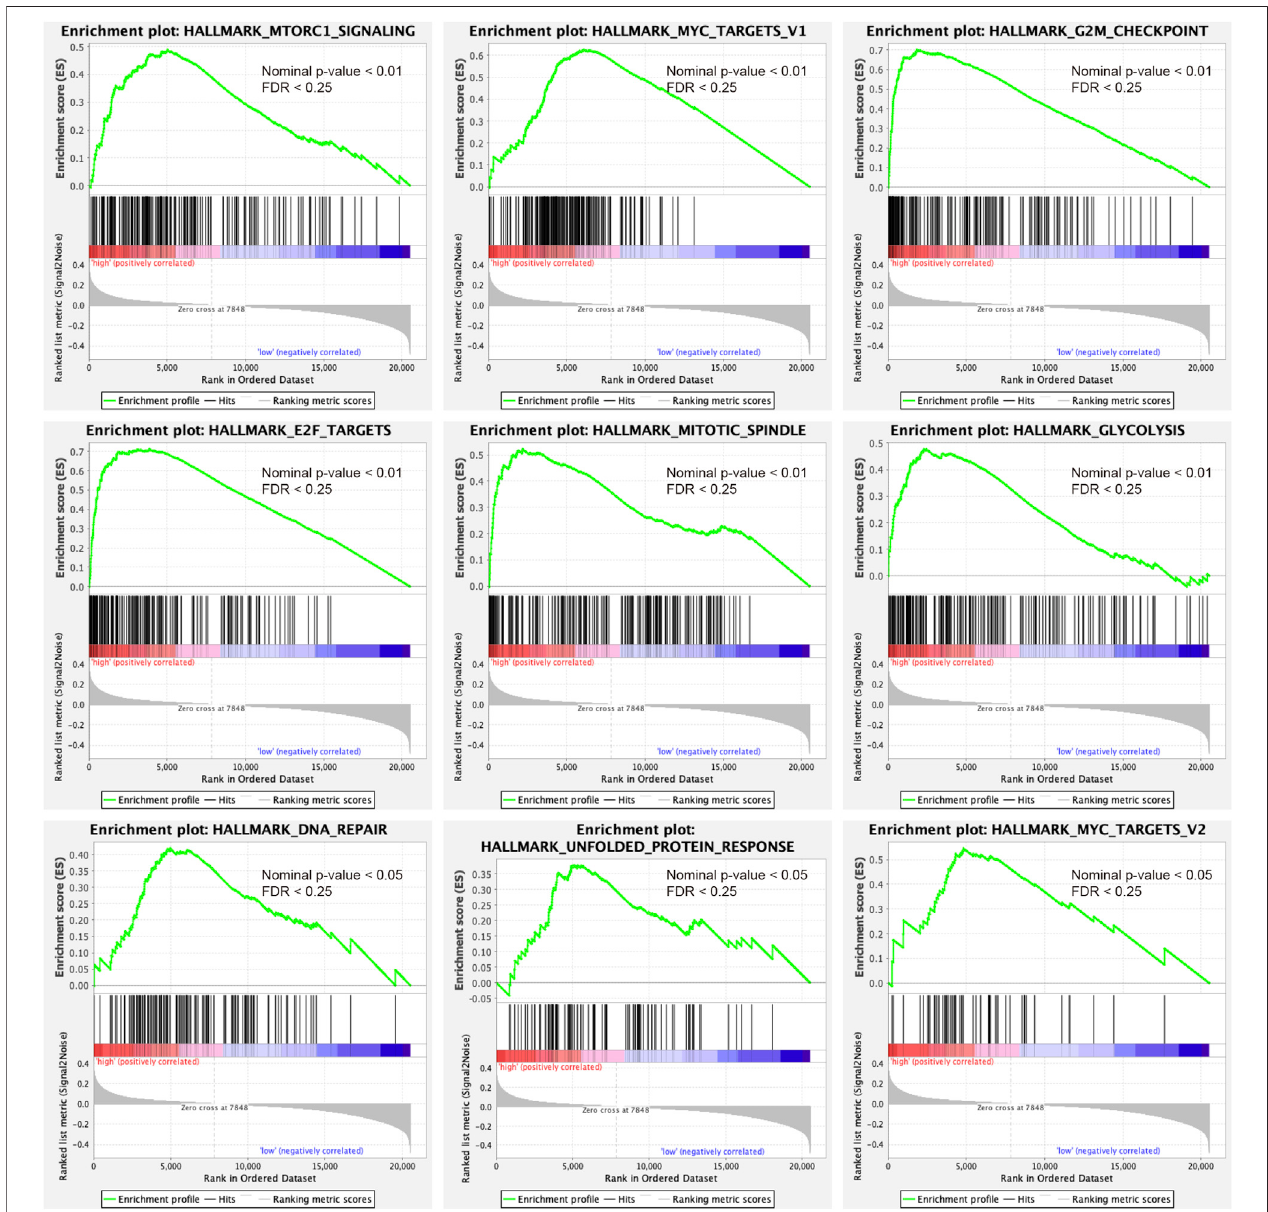
FIGURE6| Geneset enrichmentanalysisindicatedsigni fi cantenrichmentofhallmark cancer-related pathwaysin thehigh-riskgroupbasedonthe TCGAdataset. mTORC1, mammalian target of rapamycin complex 1.